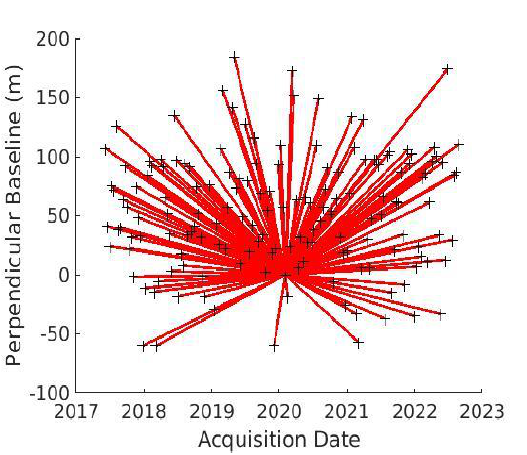
Figure 2. The baselines of the computed interferograms.